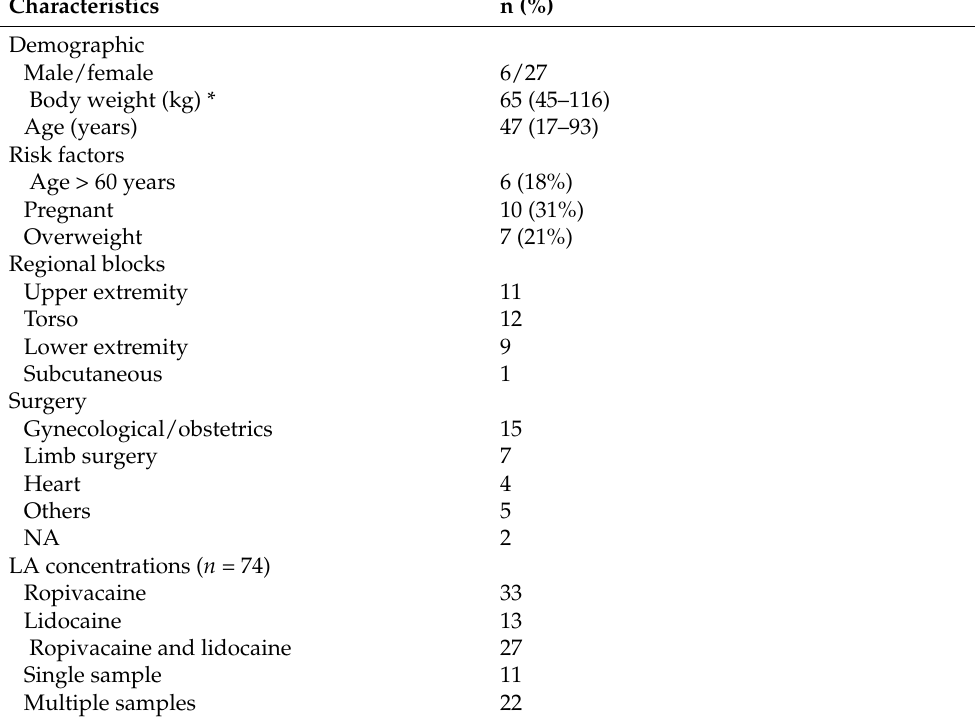
Table 1. Patients’ Table 1. Patients’ characteristics.